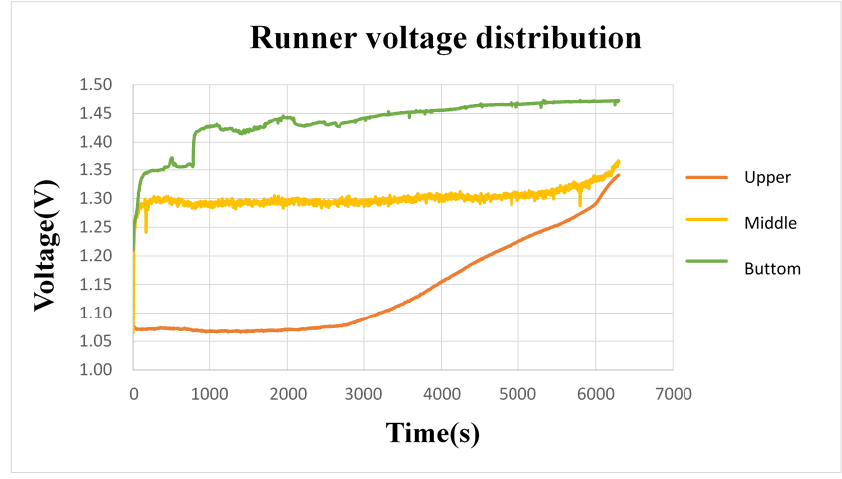
Figure 13. Charging diagram of micro-sensor embedded in VRFB.